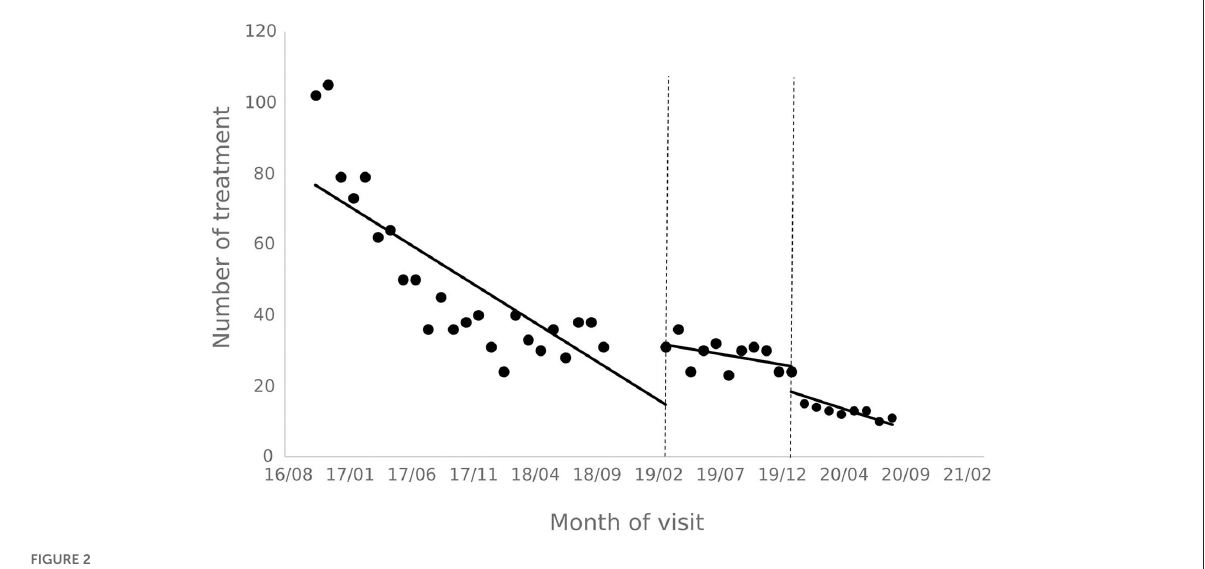
FIGURE2 Outpatient treatment of hepatitis C